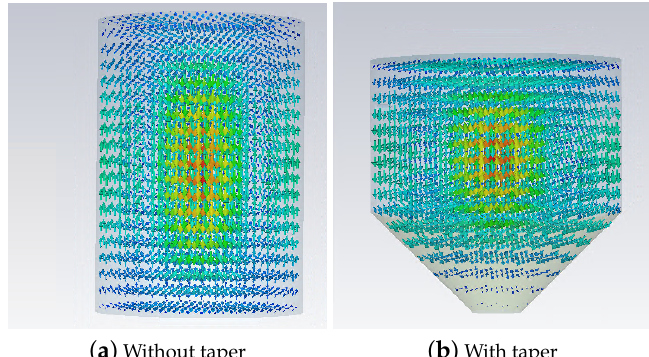
Figure 19. H 011 mode magnetic field distributions in a cylinder cavity without tapers ( a ), and with taper ( b ).